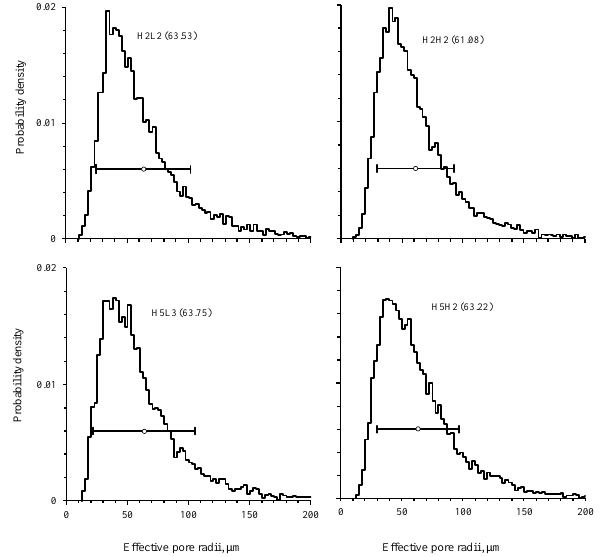
Figure 2. Probability density distributions versus pore radii for Hamra 2.0 and 0.5mm aggregate treatments (H2 and H5) and low- and high-compaction treatments (L and H). Selected replicates are shown in the figure (last number in treatment name is replicate). The number within parentheses is the sample mean pore radius in micrometers. The circle represents the average pore radii and the horizontal line indicates the standard deviation of the